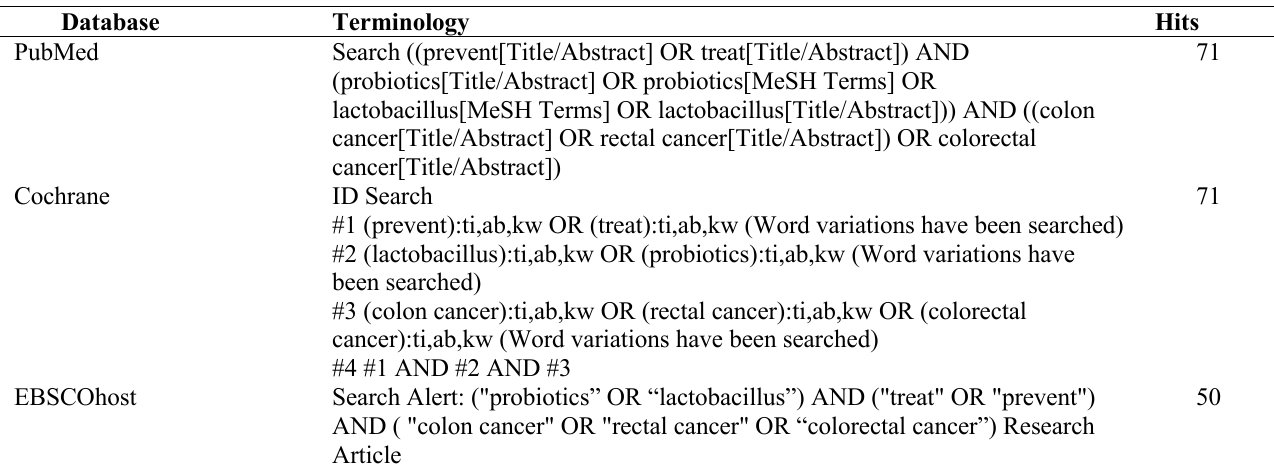
Table 1. Terminology DatabaseDatabase TerminologySearch